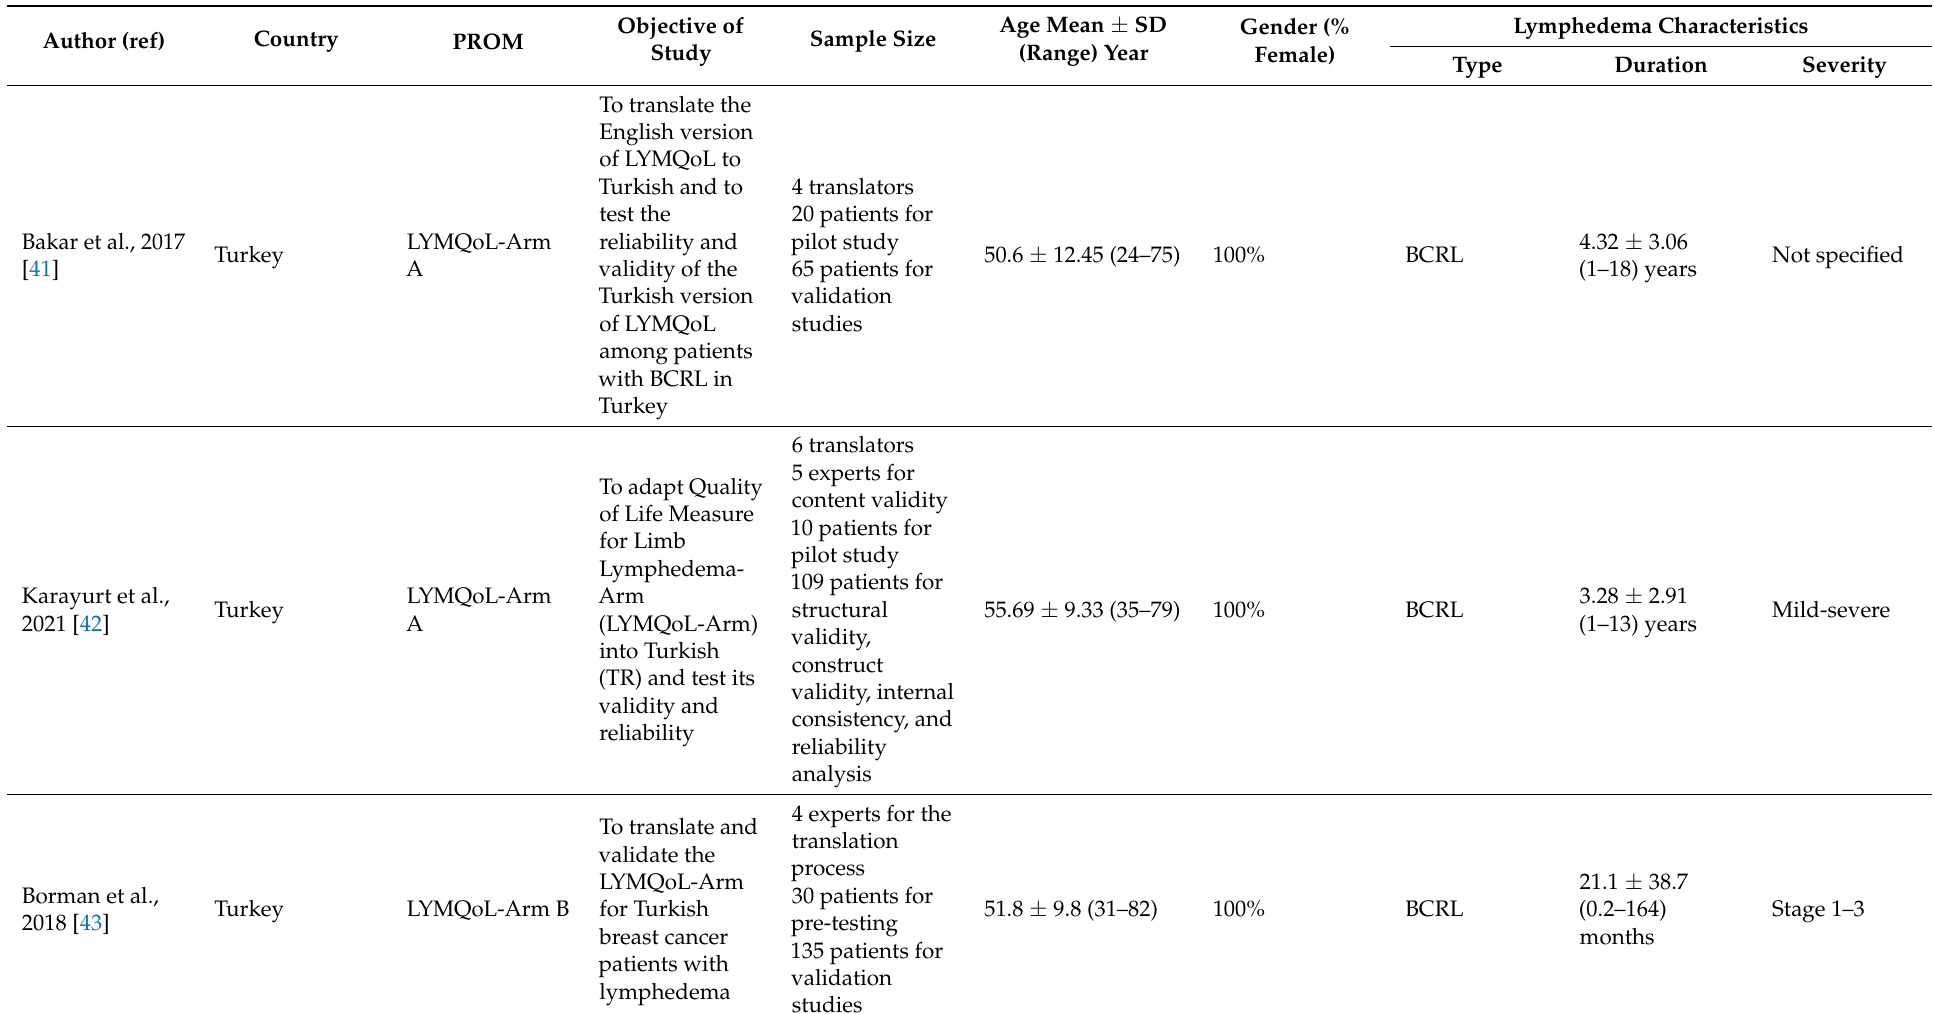
Table 3. Characteristics of included